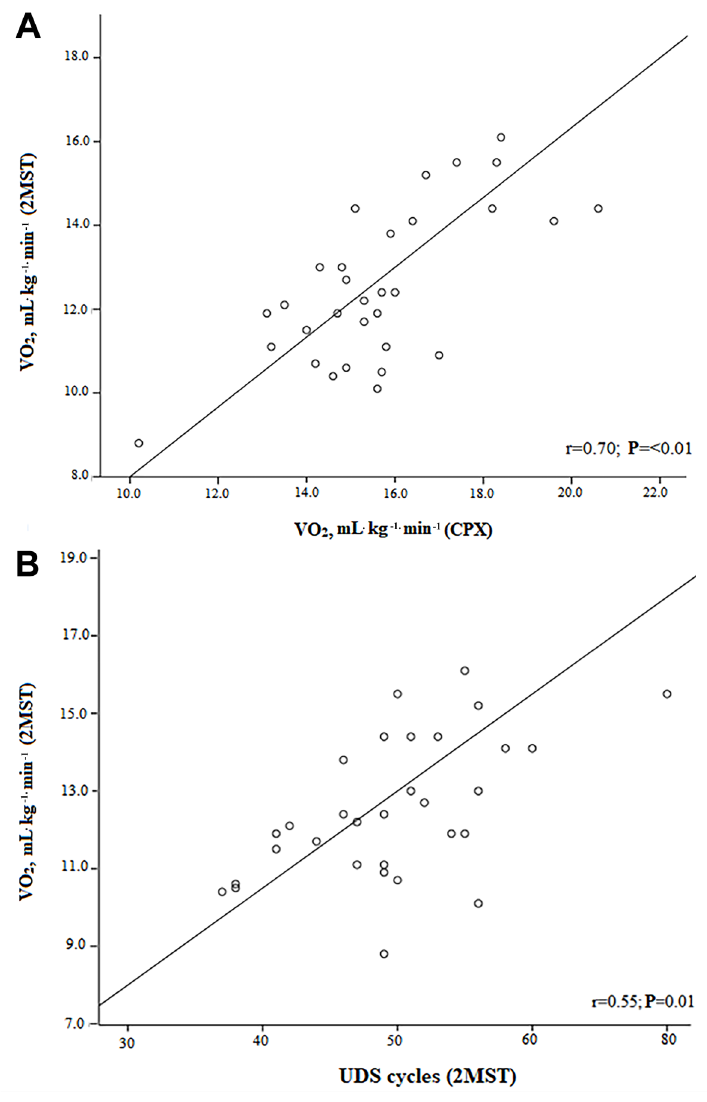
Figure 2. A , Correlation between oxygen uptake (VO 2 ) at the peak of the cardiopulmonary exercise test (CPX) and at the peak of the two-minute step test (2MST). B , Correlation between VO 2 at the peak of the 2MSTand the up-and-down step cycles